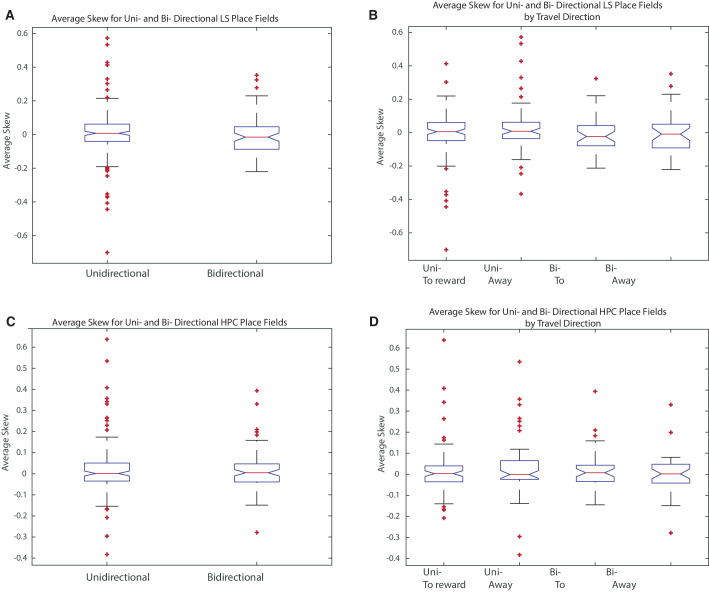
Skew is not impacted by uni- or bi- directional place fields.(A) Comparison of average skew values for uni- and bi- directional LS place fields. There is no significant difference between the means directional (two-tailed two sample t-test, t(246)=-0.19, p=.85). (B) Comparison of average skew values for uni- and bi- directional LS place fields based on travel direction. There is no significant difference between the groups (one way anova, F(3,244) = 1.05, p>0.05). (C) Same as A but for HPC place fields. The mean skew was not significantly different between uni- and bi- directional place cells (two-tailed two sample t-test, t(207)=-0.59, p=0.55). (D) Same as B but for HPC place fields. There was no significant different between the groups (one way anova, F(3,205) = 0.29, p>0.05).